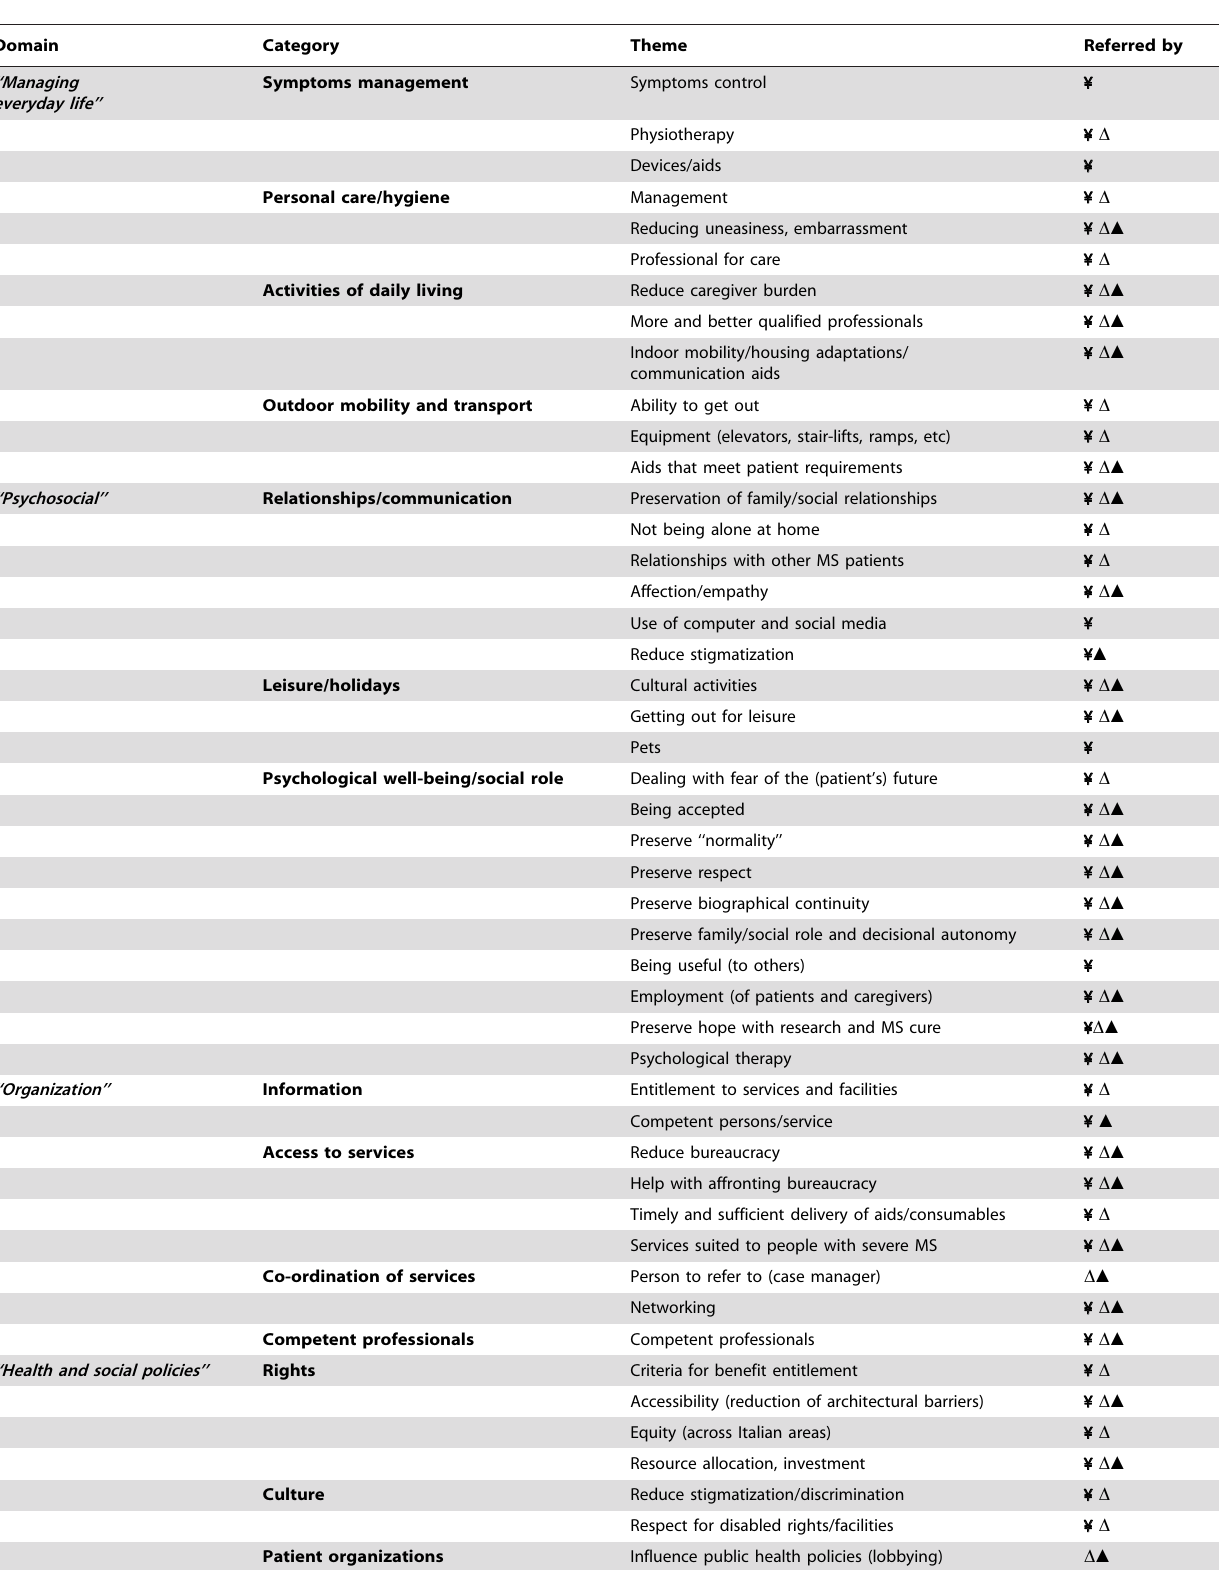
Table 4. Codification of needs into themes, categories and domains, as referred by people with severe multiple sclerosis ( ¥ ), their carers ( D ) and health professionals ( m